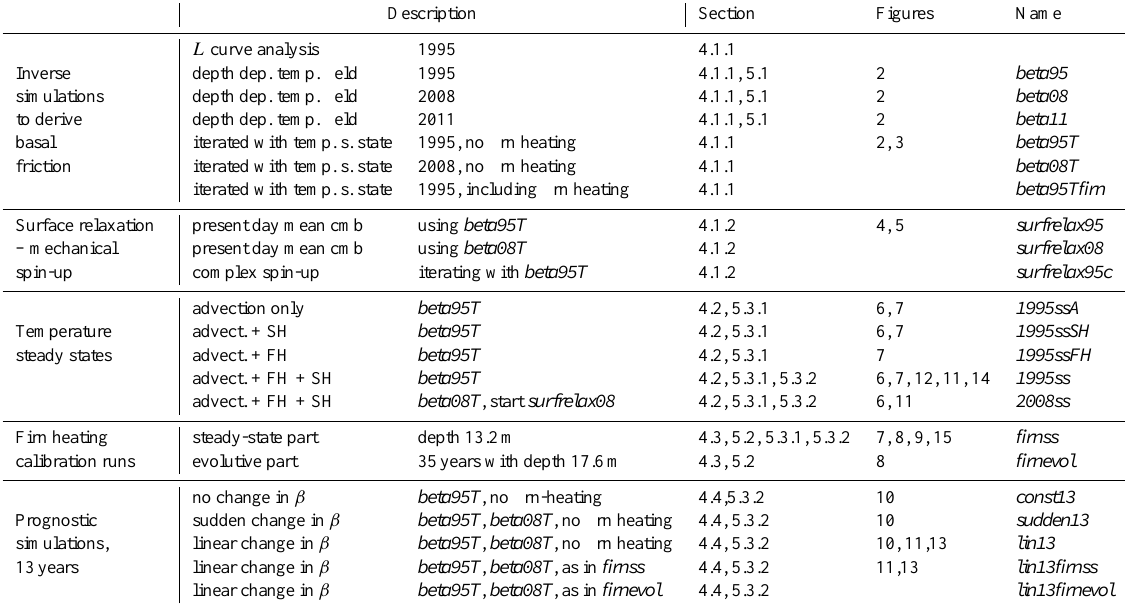
Table 2. Summary of simulations.